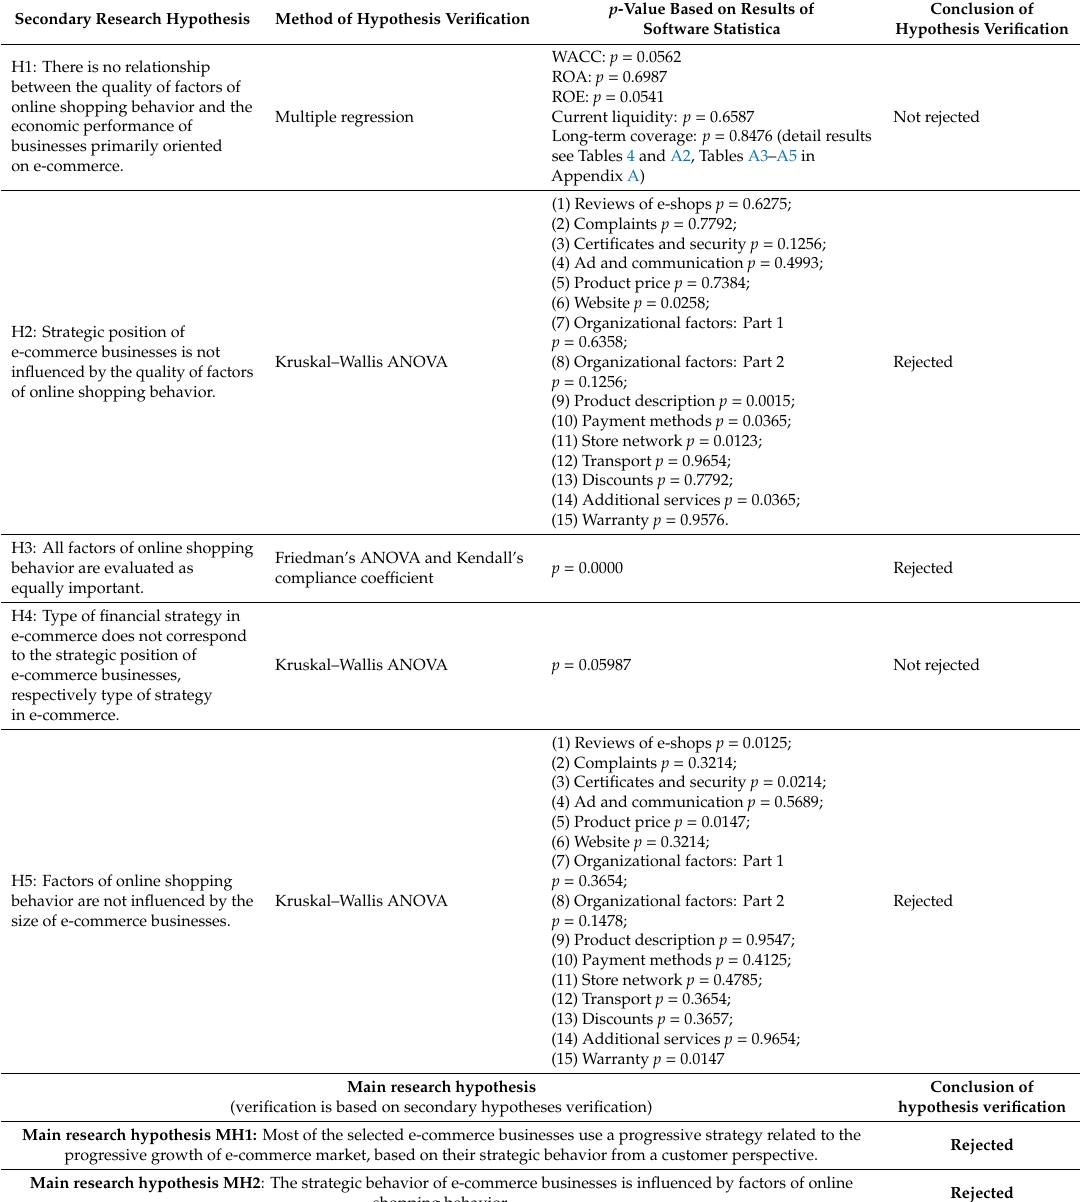
Table 9. Hypothesis verification. Source: own research in the software